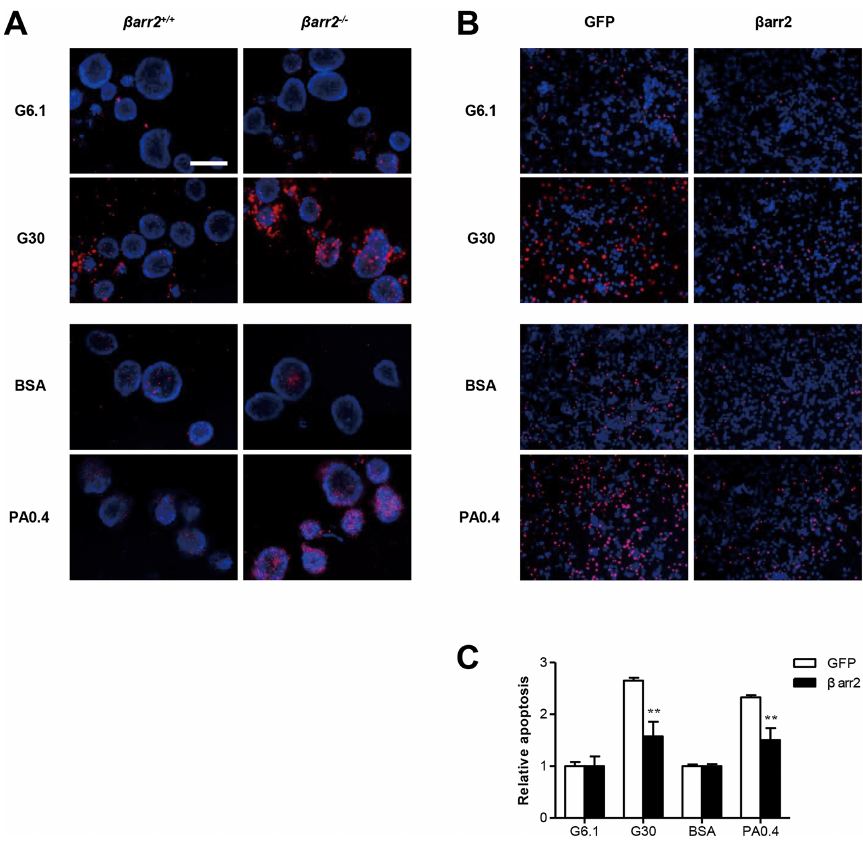
Figure 5. β arr2 protected β -cell against high glucose– and free fatty acids–induced apoptosis. (A, B) Islets isolated from 16-wk-old b arr2 +/+ and b arr2 –/– mice and INS-1 (832/13) cells infected with adenoviruses expressing GFP or β arr2 were exposed to 6.1 mmol/L (G6.1) or 30 mmol/L (G30) glucose, or BSA alone or with 0.4 mmol/L palmitate (PA0.4). Representative fluorescence micrographs after double staining with propidium iodide (red) and Hoechst 33324 (blue) of islets (A) and INS-1 (832/13) cells (B) from five indepen- dent experiments are shown. Scale bar: 200 μ m. (C) Quantitative percentage of apop- totic cells in the total INS-1 (832/13) cells (n = 5). ** P < 0.01 versus